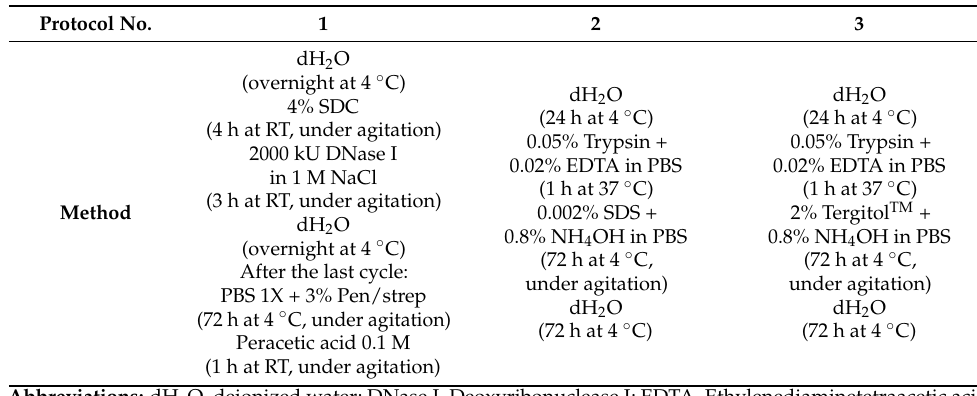
Table 1. Decellularization methods. Detergent-enzymatic protocols tested on human esophageal tubules and patches. Agitation speed was 100